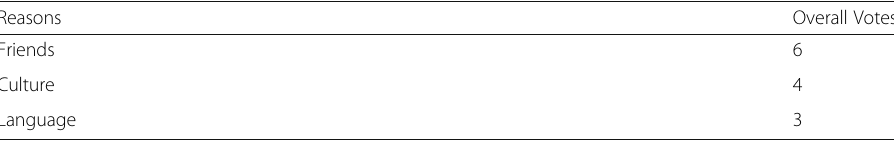
Table 2 Motivational Reasons